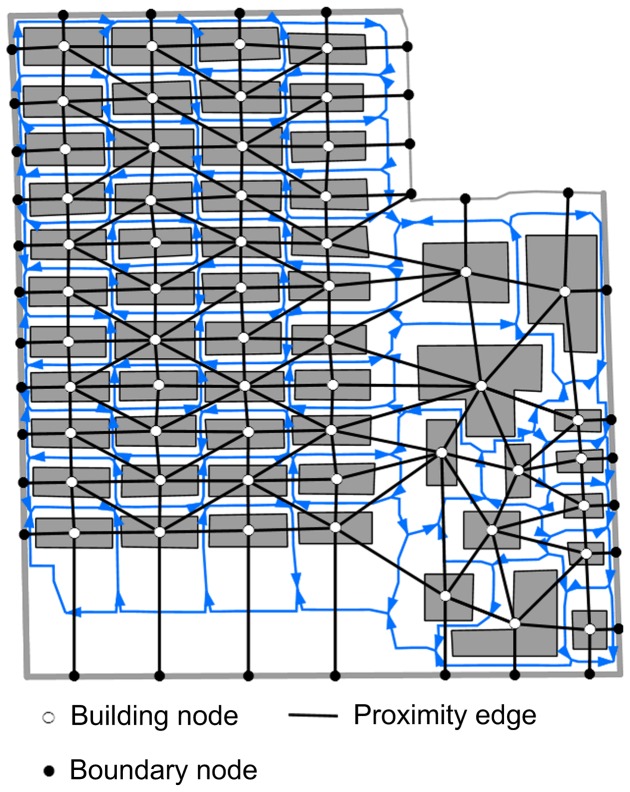
Construction of initial proximity graph from the skeleton graph.Each skeleton arc is corresponding to a proximity edge in the constructed proximity graph. There was a one-to-one correspondence between building and building node and a one-to-n (n ≧1) correspondence between boundary line segment and boundary node in the graph. The number of the boundary nodes on each boundary segment depends on the number of involved proximity relationships.